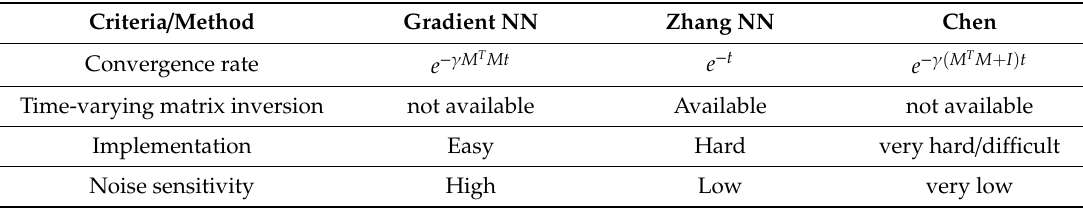
Table 1. Comparison of di ff erent types of DNN (dynamic neural network) concepts (the traditional ones) for matrix